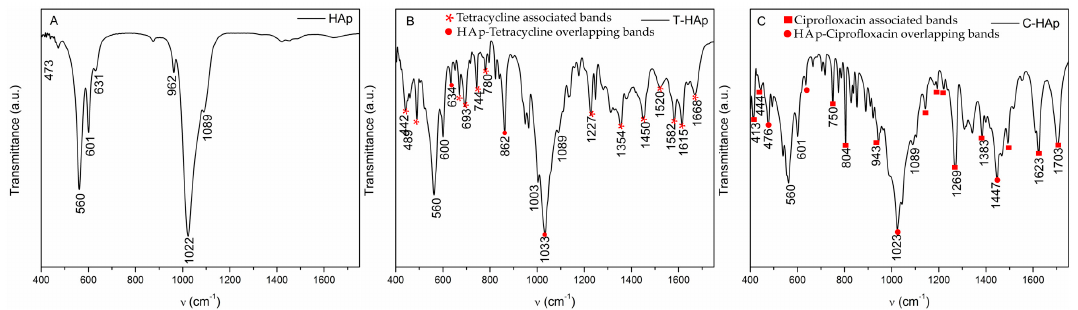
Figure 7. FTIR spectra of HAp ( A ); T-HAp ( B ) and C-HAp ( C ).